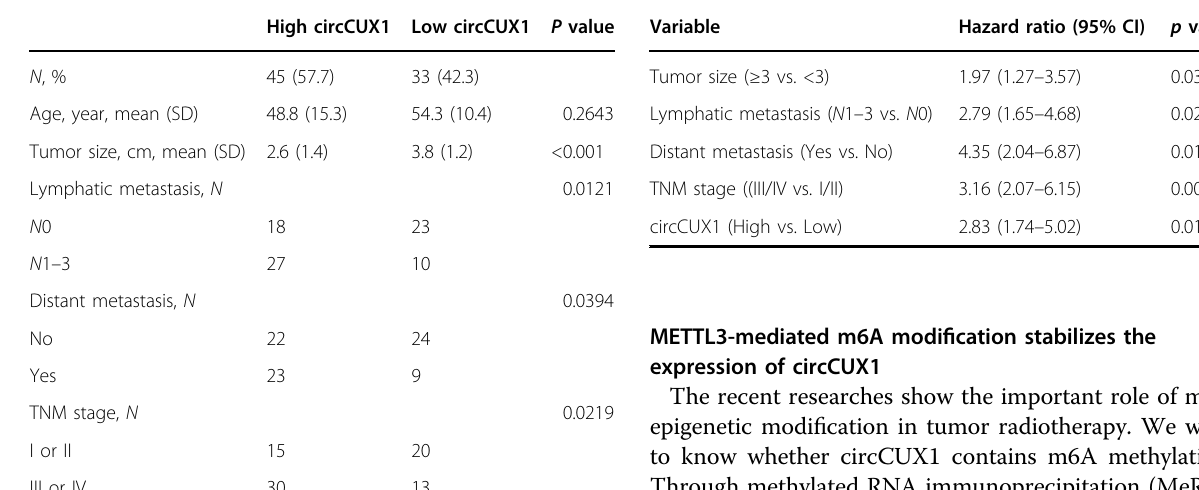
Table 2 Association of HPSCC characteristics and circCUX1 expression.